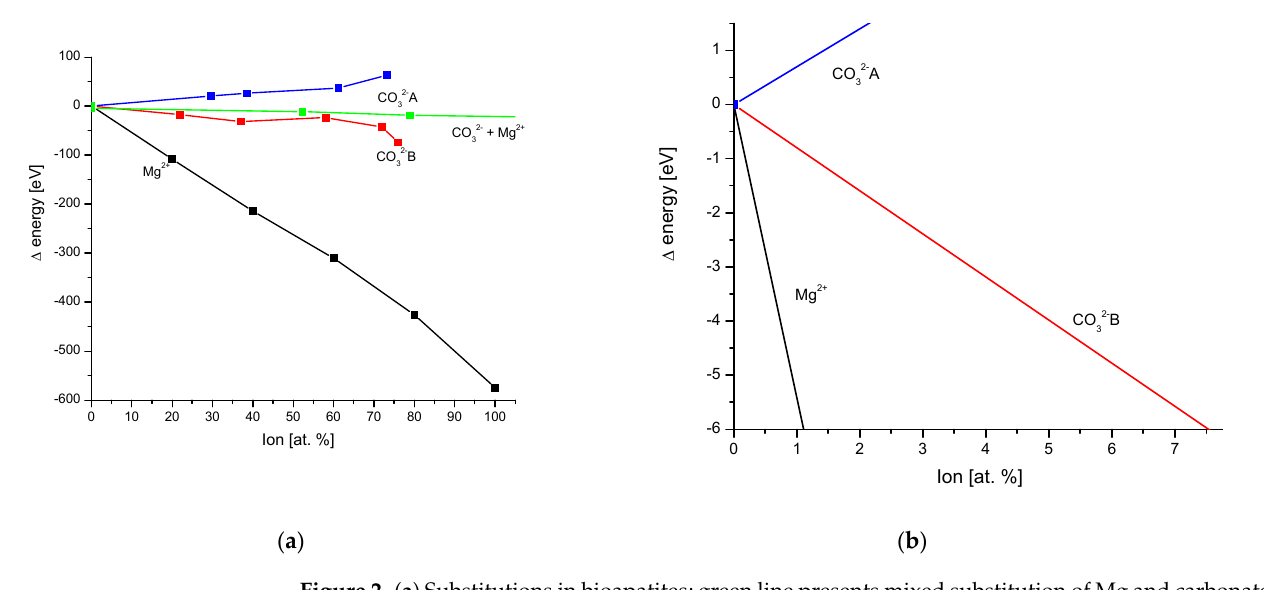
Figure 2. ( a ) Substitutions in bioapatites; green line presents mixed substitution of Mg and carbonates; ( b ) real biological substitutions, limited by the true ionic concentrations of Mg and carbonates. Origin of basic data: Mg 2+ from [36], Mg 2+ + CO 32 − from [40], CO 32 − , substitution A from [39], CO 32 − , substitution B from [38].